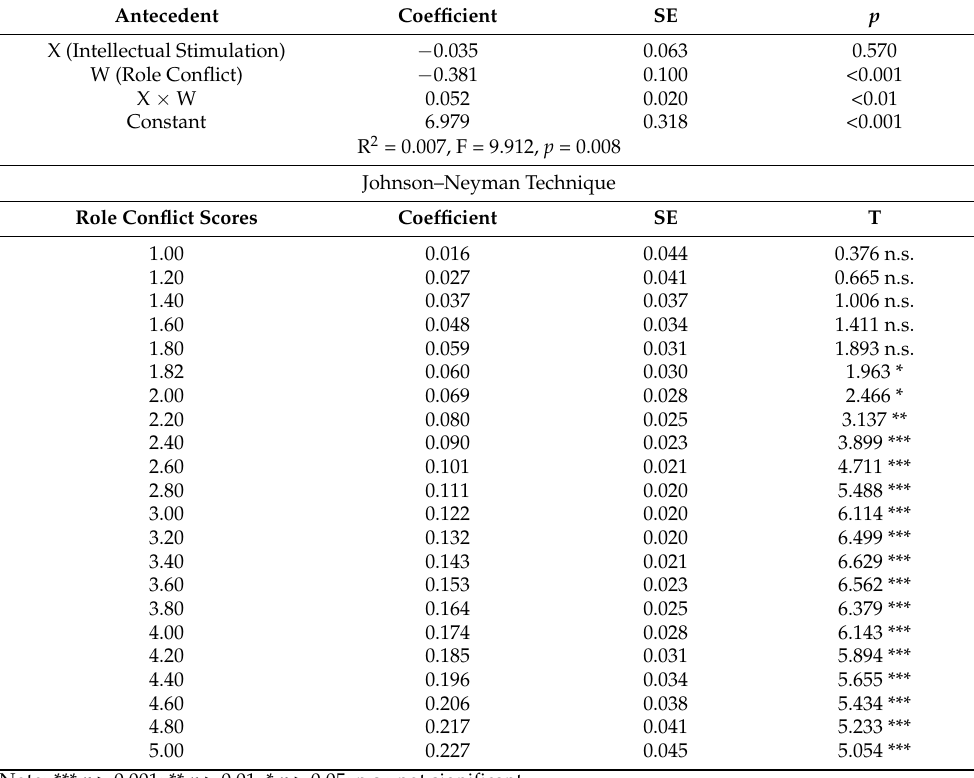
Table 3. Results of regression analysis examining the moderation of the influence of intellectual stimulation on intellectual engagement by role conflict and the conditional influence of role conflict.